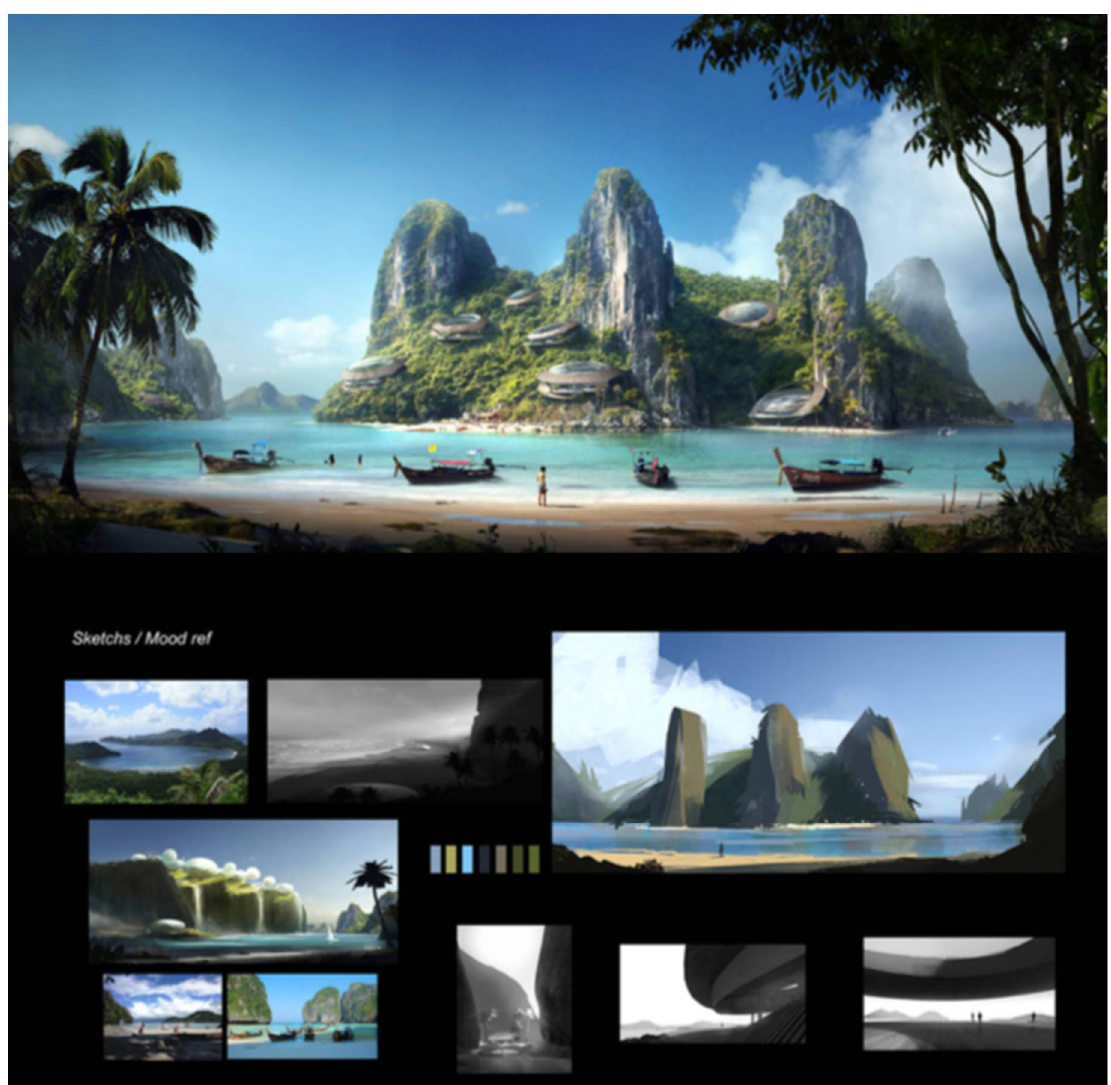
Figure 3. Island Rings. Digital matte painting and personal project of Thomas Dubois. Above the final image, also adopted by Chaosgroup to advertise V-Ray for C4d, with which some portions of the image have been rendered. Below a moodboard with the study of landscape, color, and